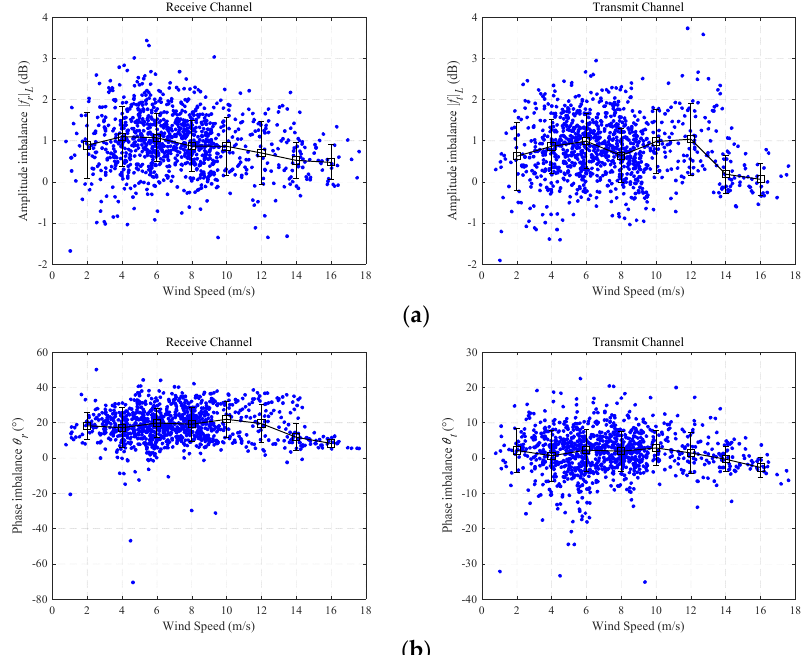
Figure 4. ( a , b ) The amplitude and phase imbalance of GF-3 SAR imagery of sea surface observation for receive and transmit channel. Upper row represents the amplitude imbalance variation relative to wind speed, and down row represents the phase imbalance variation relative to wind speed. Besides wind speed, the radar parameter of incidence angle was also worthwhile to investigate. Figure 5 presents the amplitude and phase imbalance relative incidence angle for both transmit and receive channel, respectively. It can be seen that the amplitude of transmitting channel is slightly larger than that of receiving channel. Moreover, the phase deviation of the transmitting channel is smaller than that of the receiving channel.